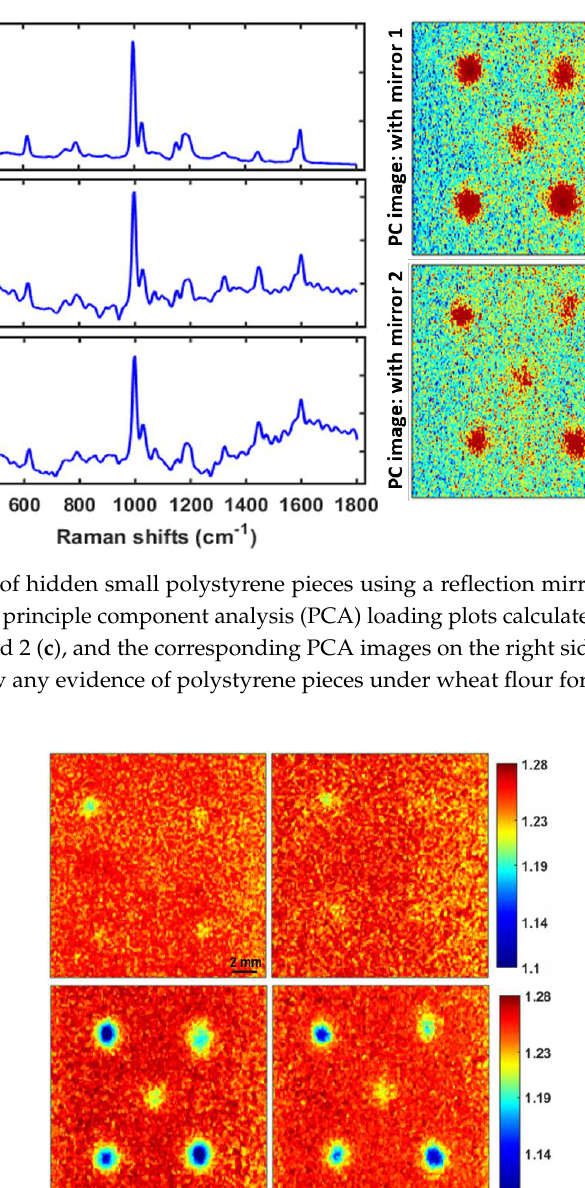
Figure 8. SAM generated Raman images of small polystyrene pieces mapped without (upper row) and with (lower row) the reflection mirror for two replicates. (Representation of Sample S4 with supervised analysis method SAM).